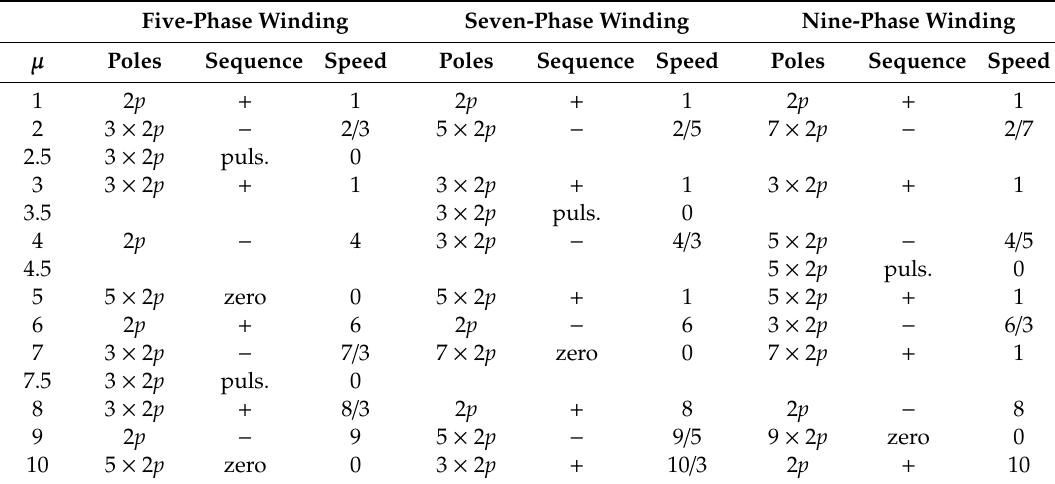
Figure 10. Time harmonics acting in multiphase winding: ( a ) harmonics suitable for injection, ( b ) harmonics inappropriate for injecting.